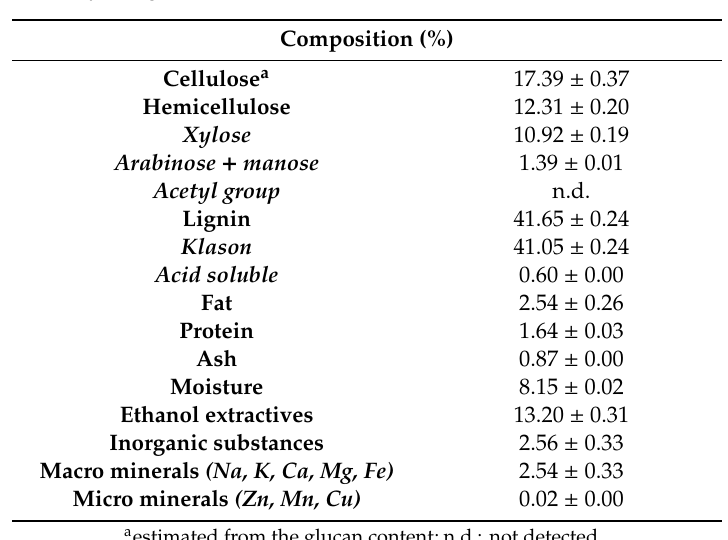
Table 2. Chemical composition of Pinus pinaster bark, expressed as percentage of dry raw material weight (composition by 100